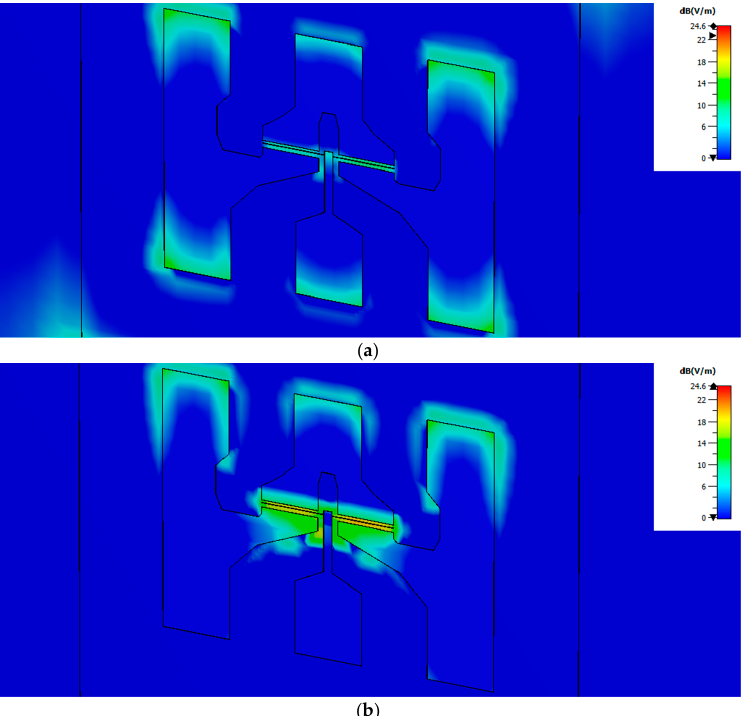
Figure 6. Spatial distributions of the module of the normalized electric field inside the transistor channel under illumination at 0.15 THz, ( a ), and 0.30 THz. ( b ) The maximum values of the normal- ized electric field inside the channel are 10.56 dB and 20.41 dB for excitation at 0.15 and 0.30 THz, respectively, as displayed in Tables 1 and 2. Black solid lines indicate the contour of the top side transistor electrodes and are a guide to the eye.